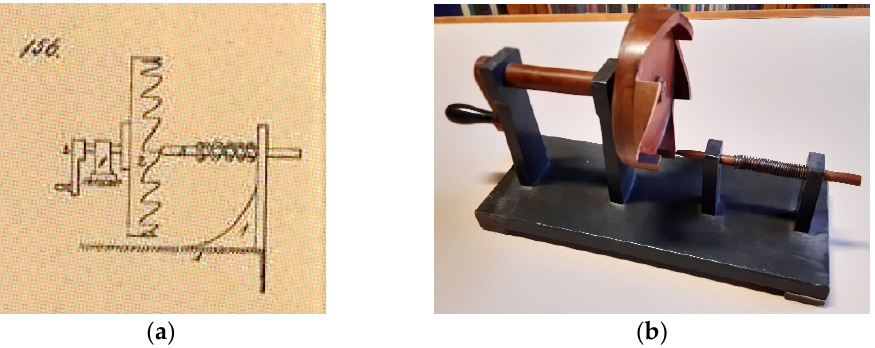
Figure 2. A model of lylindrical cam disk: ( a ) in the treatise of Masi [6]; ( b ) the corresponding wooden model at the University of Bologna.